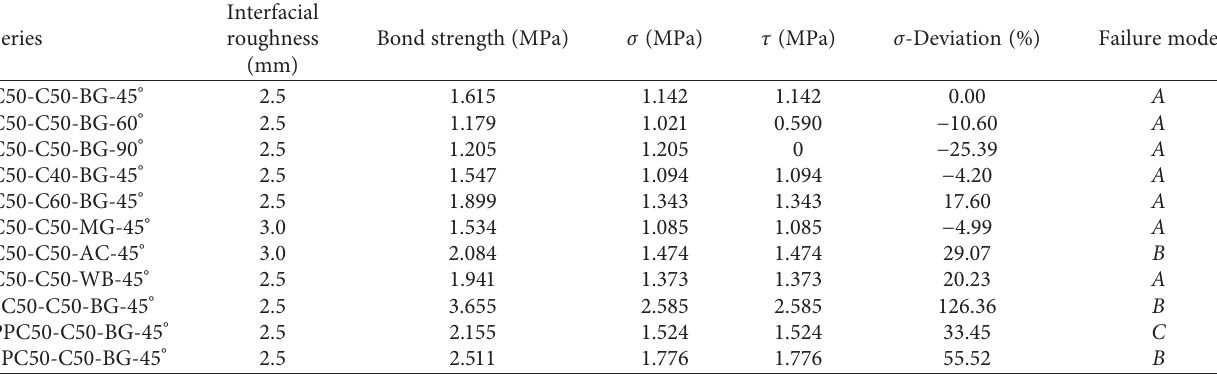
Table 5: Axial tensile testing